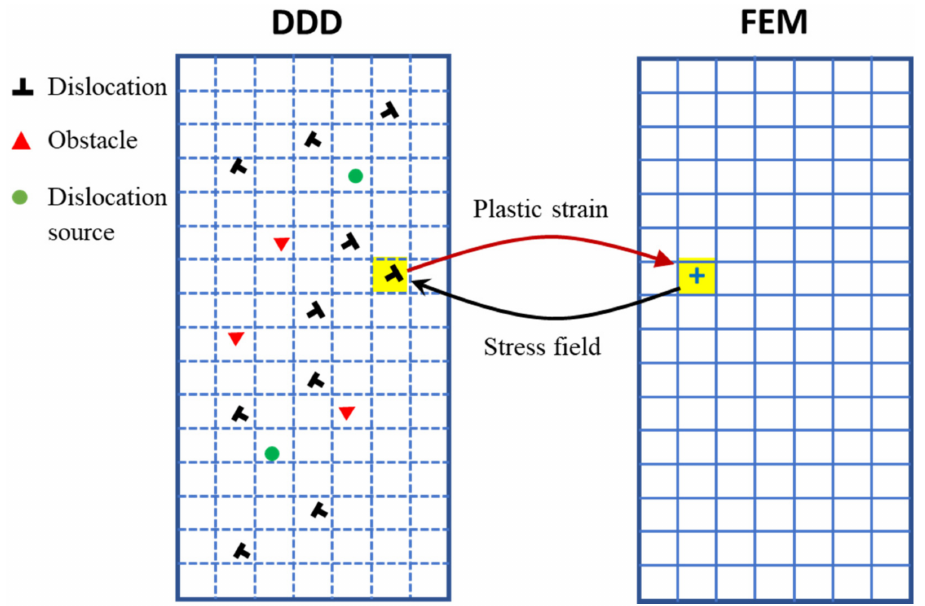
Figure 1. Schematic of the coupling scheme of DCM (Yellow block represents the single element in FEM